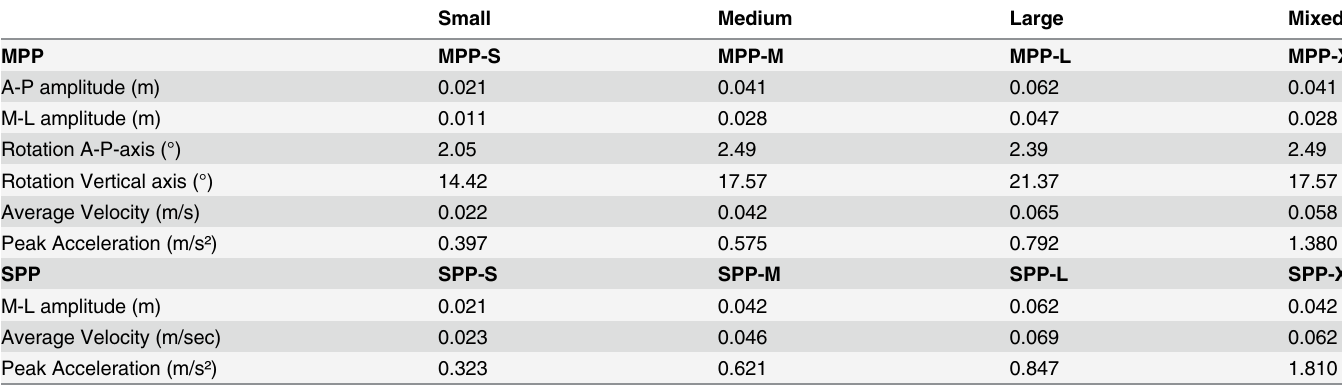
Table 1. Platform characteristics during the eight different